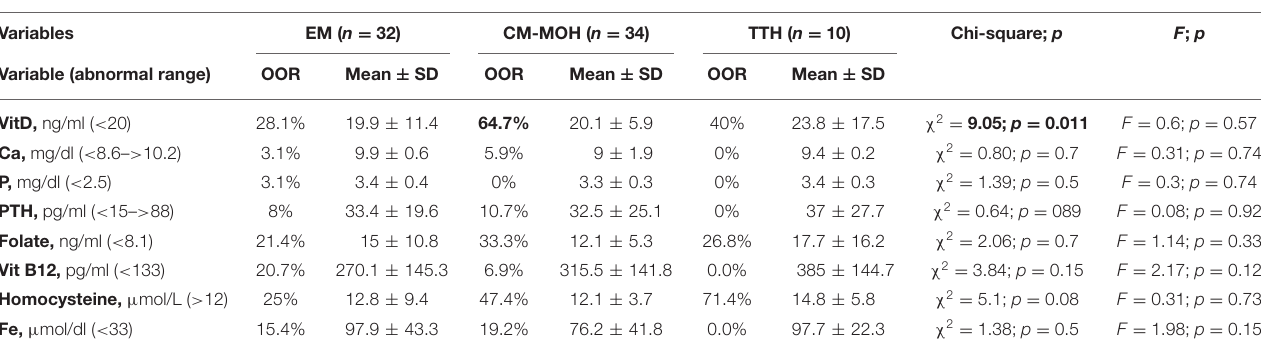
TABLE 3 | Main biochemical parameters.